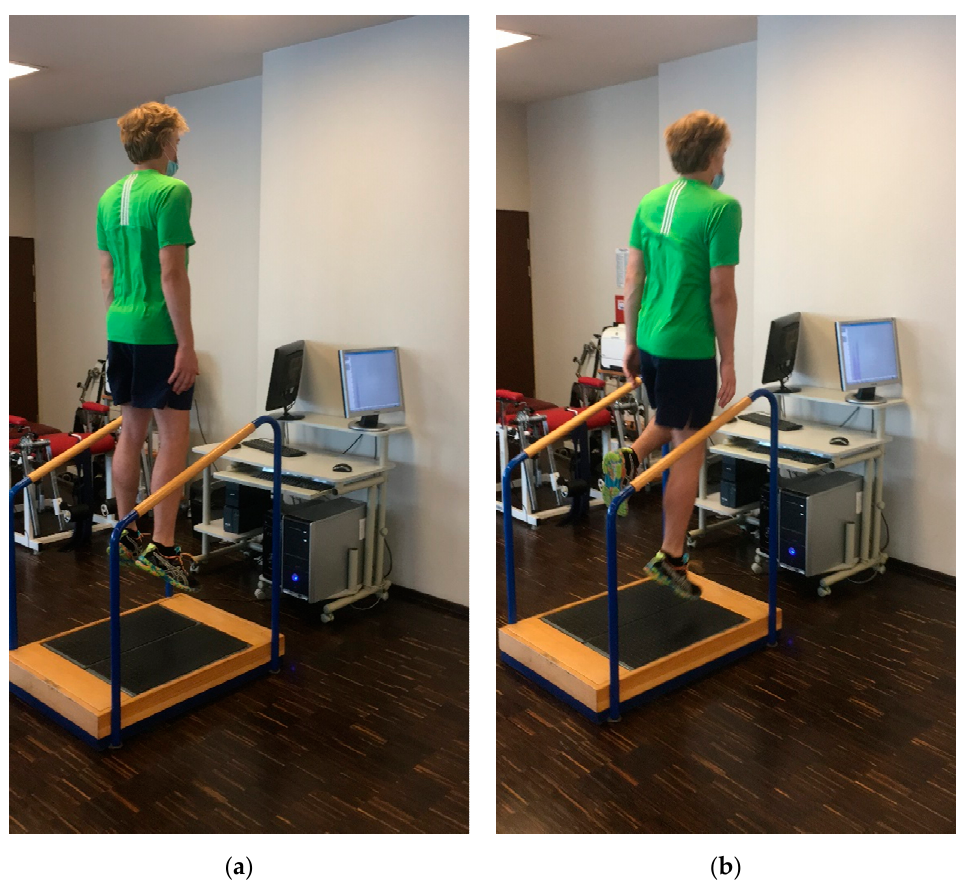
Figure 2. ( a ) Two-legged vertical hop; ( b ) one-legged vertical